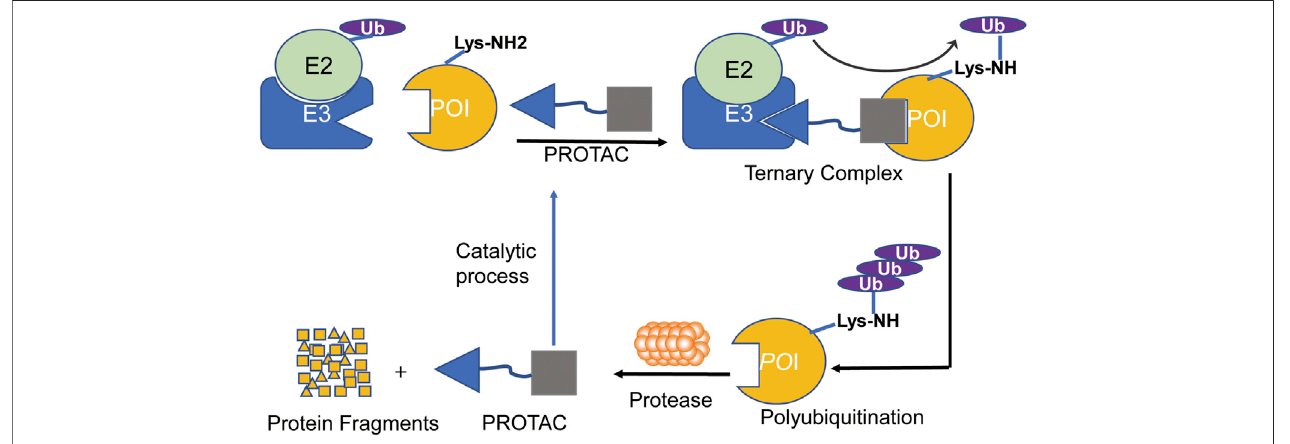
FIGURE2| TheprocessofPROTAC-mediatedubiquitinationandproteasomaldegradationofPOI.PROTACiscomposedofaligandthatbindstotheE3ubiquitin ligase and a ligand that binds to the target protein through a linker, which can induce the polyubiquitination and proteasome degradation of the target proteins in cells.